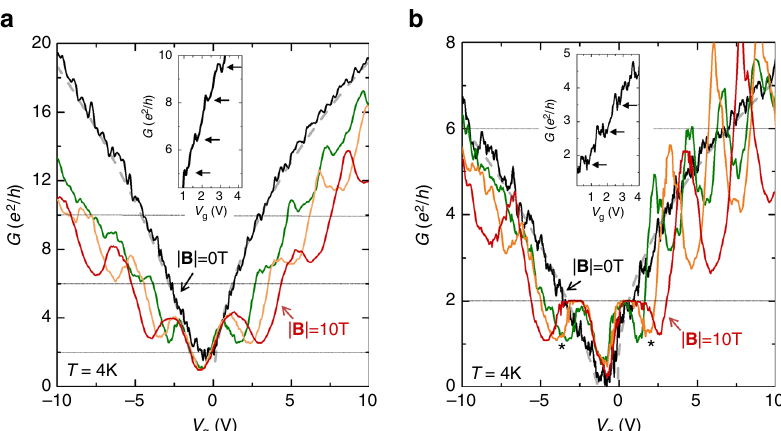
Fig. 2 CQS effect. a Conductance G vs gate voltage V g in a nanoconstriction (Sample type 1) with low edge roughness at different magnetic fi elds | B | = 0 T (black), 6 T (green), 8 T (orange), and 10 T (red). Gray-dashed lines are fi t to the data, G / Δ V g 410 Ω . Inset shows periodic conductance modulations with step heights Δ G ~ 2 e 2 /h. b G ( V g ) in a nanoconstriction with larger edge disorder (Sample type 2) at different magnetic fi elds | B | = 0 T (black), 6 T (green), 8 T (orange), and 10 T (red). Gray-dashed lines are fi t to the data, G / Δ V g R c in this device is 518 Ω . Inset shows periodic conductance modulations with step heights Δ G ~ e 2 / h (Fig. 2b). Speci fi cally, we achieve an edge roughness ≤ 1 nm in Sample type 1 (Supplementary Fig. 3 and Supplementary Note 2).